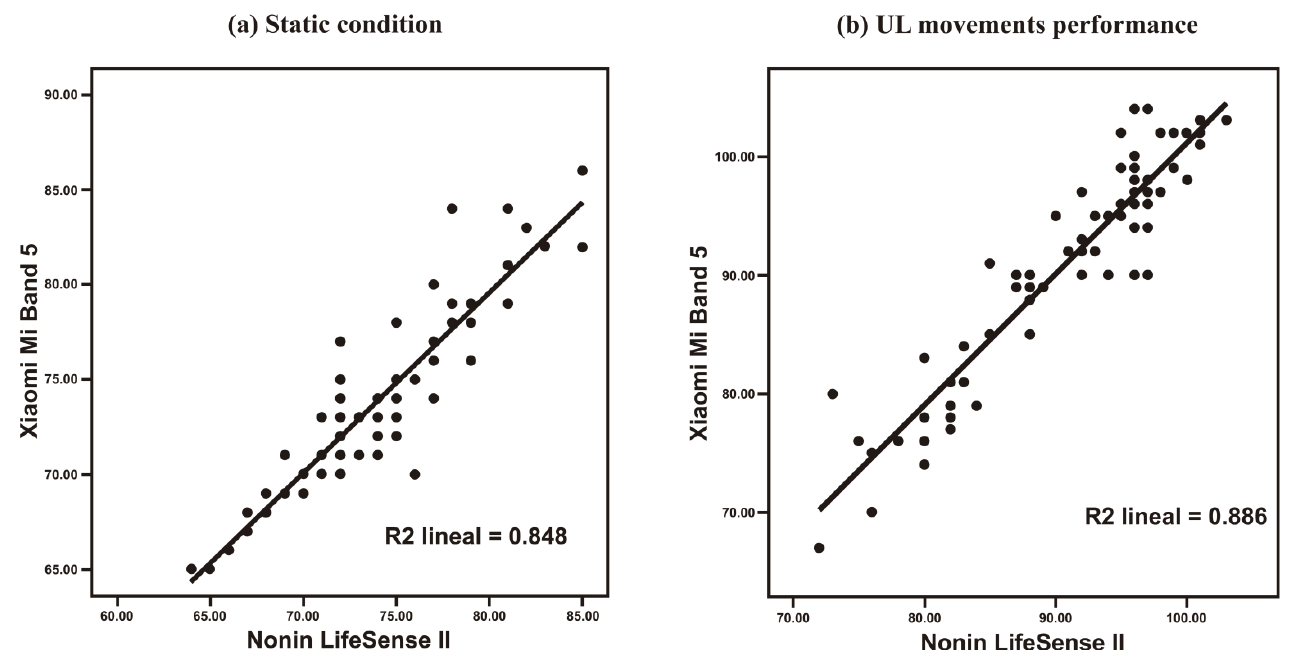
Figure 2. Scatter diagrams between the heart rate measured by Nonin Lifesense II and the heart rate measured by Xiaomi Mi Band 5 wristband during a static posture ( a ) and dynamic condition ( b ). Both XMB5 and NLII systems registered similar HR readings in the static condition: 73.80 ± 4.79 and 73.97 ± 4.61, respectively. During the performance of UL movements, both systems also registered similar readings: 90.33 ± 9.38 for XMB5 and 90.20 ± 7.96 for Nonin medical equipment.